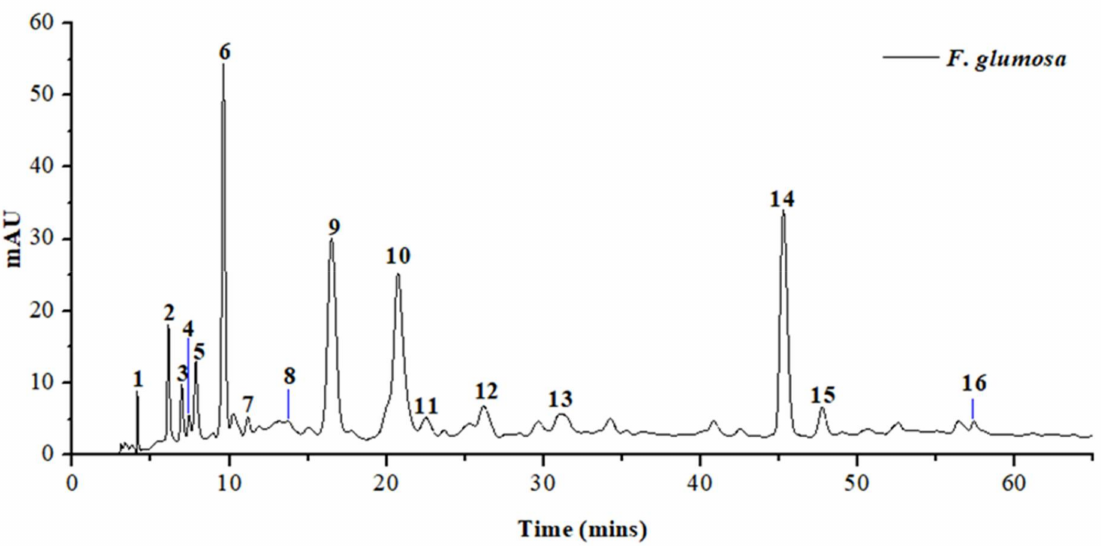
Figure 5. High-performance liquid chromatography-UV (HPLC-UV) chromatogram of EA fraction of Ficus glumosa at wavelength 280 nm. Table 2. High-performance liquid chromatography-electrospray ionization tandem mass spectrometry (HPLC-ESI-MS/MS) data of compounds that were obtained from the EA fraction of Ficus glumosa stem bark. Peak